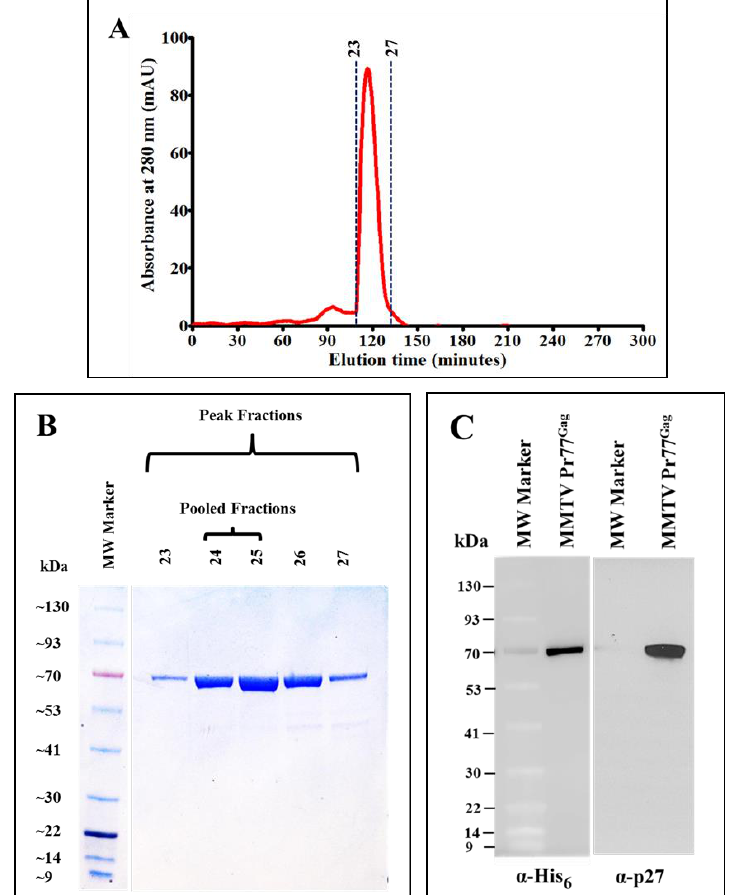
Figure 6. Resolution of IMAC-purified recombinant Pr77 Gag -His 6 -tag fusion protein by size exclusion chromatography and western blot analysis. ( A ) Absorbance versus elution time chromatogram of eluted fractions after size exclusion chromatography; ( B ) Coomassie Brilliant Blue-stained SDS-PAGE analysis of peak fractions 23 to 27, showing the resolution of purified recombinant MMTV Pr77 Gag expressed from AK7; ( C ) western blot analysis of pooled peak fractions of purified MMTV Pr77 Gag -His 6 -tag fusion protein analyzed with α -His 6 and α -p27 monoclonal antibodies, respectively.